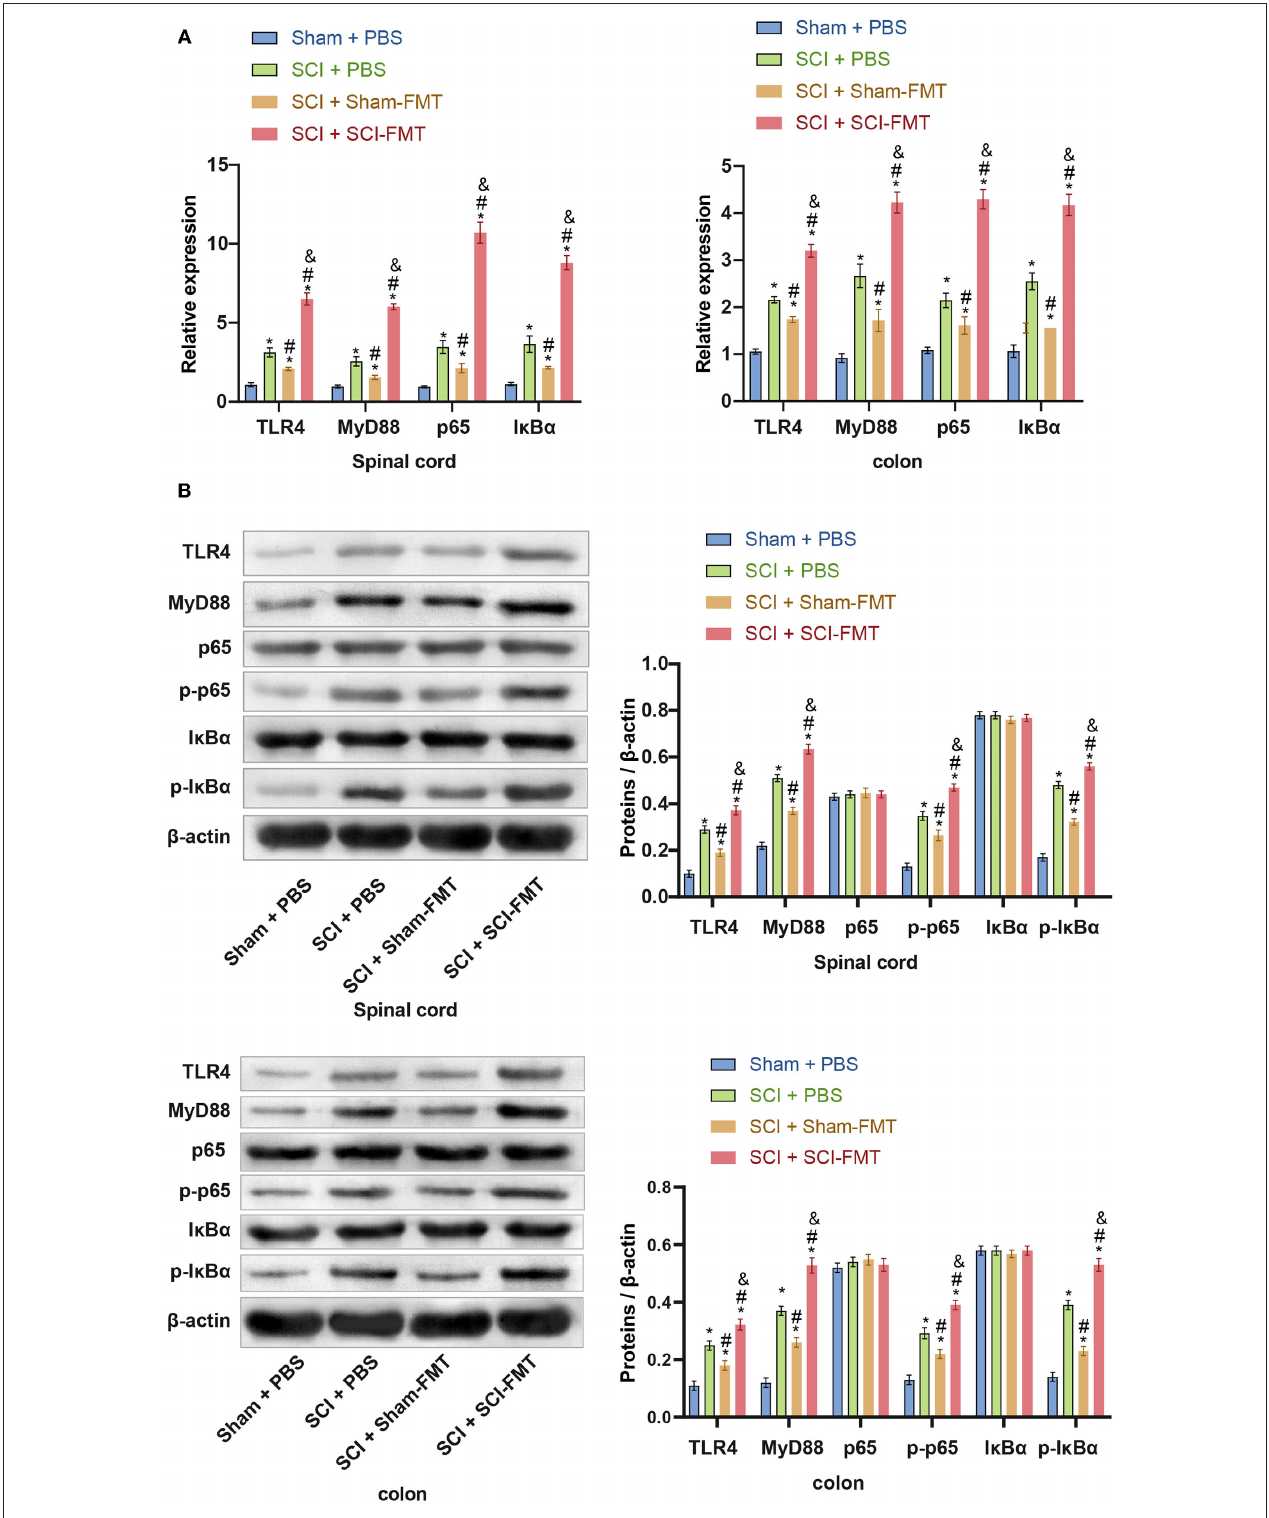
FIGURE 6 | The imbalance of the gut microbiota in SCI mice could activate the TLR4/MyD88 signaling pathway. (A) The expression of TLR4, MyD88, p65, and I κ B α in the spinal cord and colon tissues. (B) Imbalance of the gut microbiota of SCI mice could promote the protein expression of TLR4, MyD88, p-p65, and p-I κ B α . *, P < 0.05 compared with the Sham + PBS group. #, P < 0.05 compared with the SCI + PBS group. &, P < 0.05 compared with the SCI + Sham-FMT group. Multiple comparisons in groups were evaluated by one-way analysis of variance n = 5.